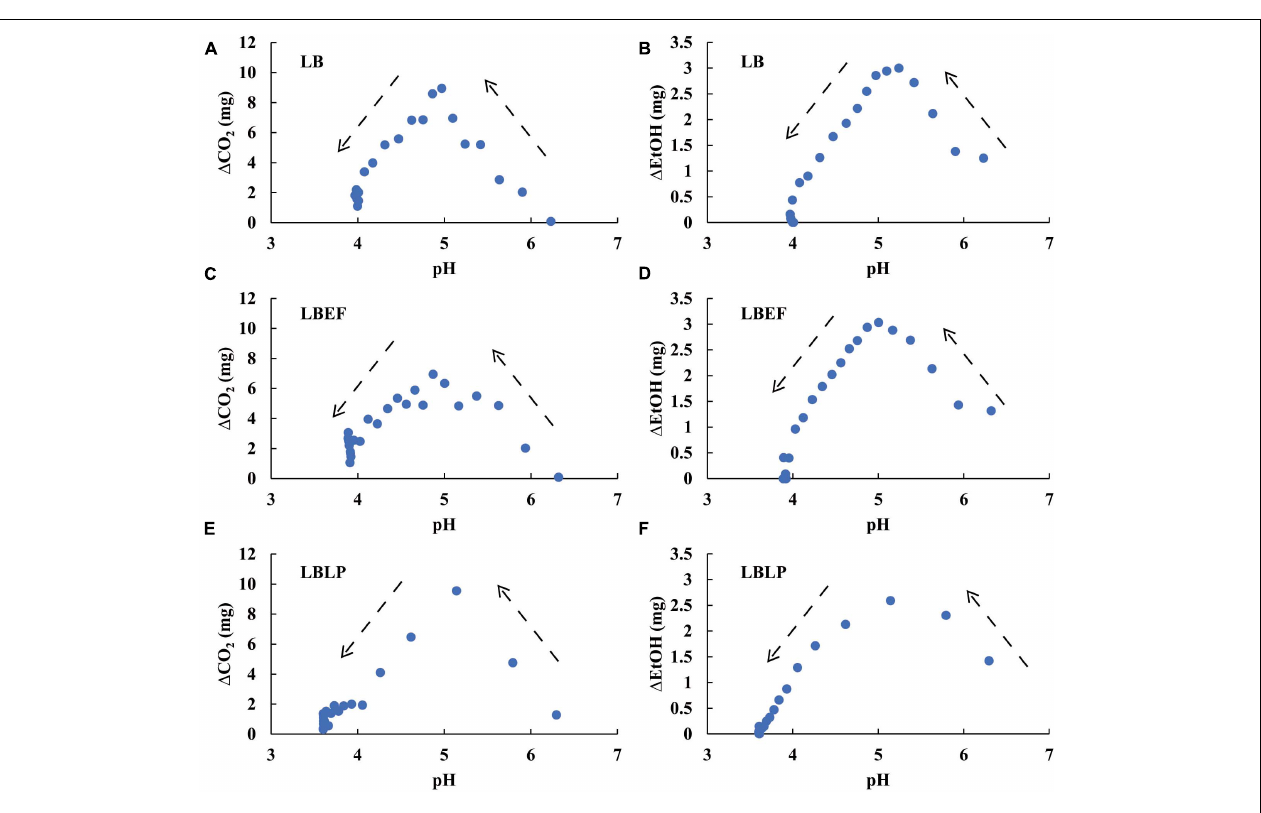
FIGURE 7 | The relationships between the pH of the three microbial samples and the differential variables of both CO 2 production (A,C,E) and EtOH production (B,D,F) , where (cid:49) CO 2 = CO 2 ( t i ) − CO 2 ( t i - 1 ) and (cid:49) EtOH = EtOH( t i ) − EtOH( t i - 1 ), both calculated with t i − t i - 1 = 2 h, i = 0, 1, ... , n . The arrows denote the time course of decreasing